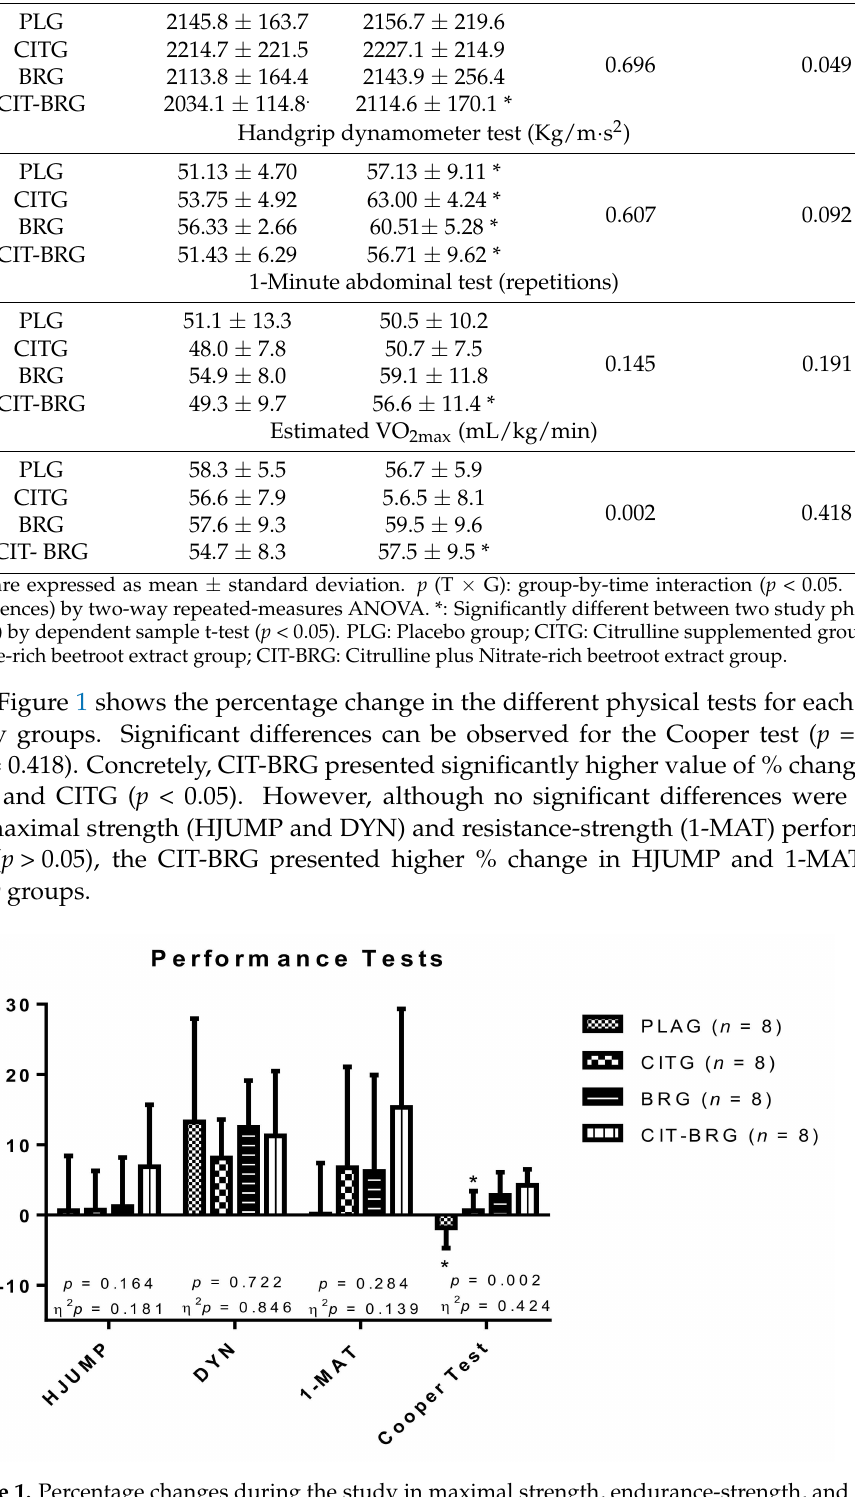
Figure 1. Percentage changes during the study in maximal strength, endurance-strength, and aerobic power in the triathletes. Data are presented as mean ± standard deviation. ∆ : ((T2 − T1)/T1) × 100. *: Significant differences with respect to CIT-BRG ( p <